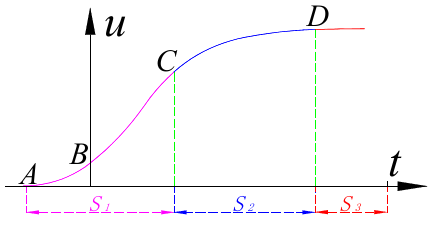
Figure 11. The whole process curve of surrounding rock deformation.